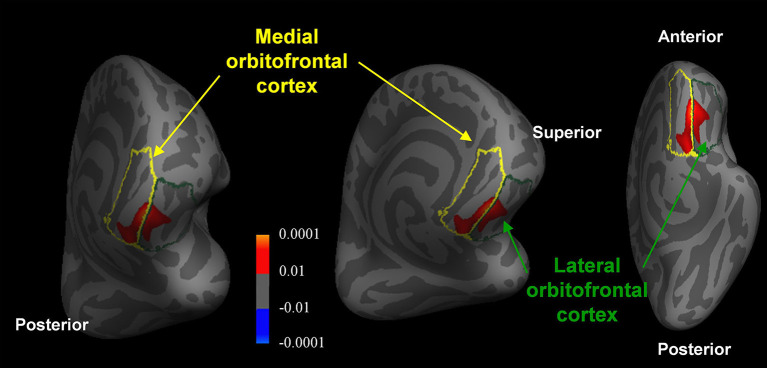
Reduced orbitofrontal cortex thickness in patients with MCI compared with healthy controls (Monte-Carlo corrected, p < 0.01). The p-values of the clusters are represented by warm (healthy controls > MCI patients) and cool (MCI patients > healthy controls) colors.